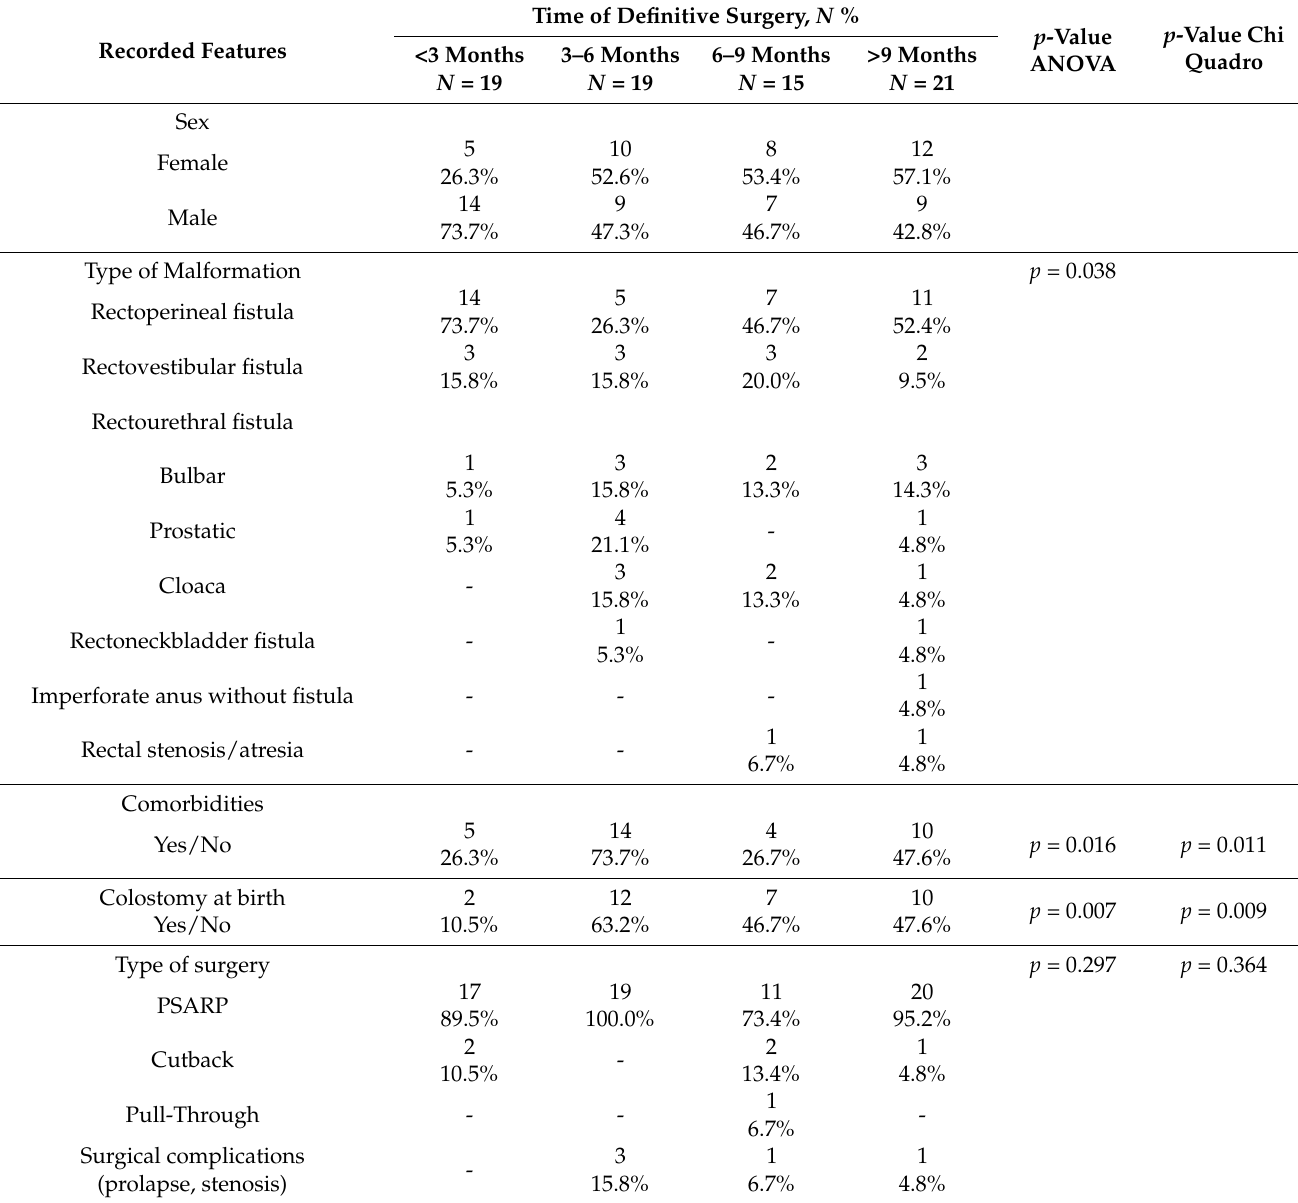
Table 2. Features of the patients according to the time of definitive